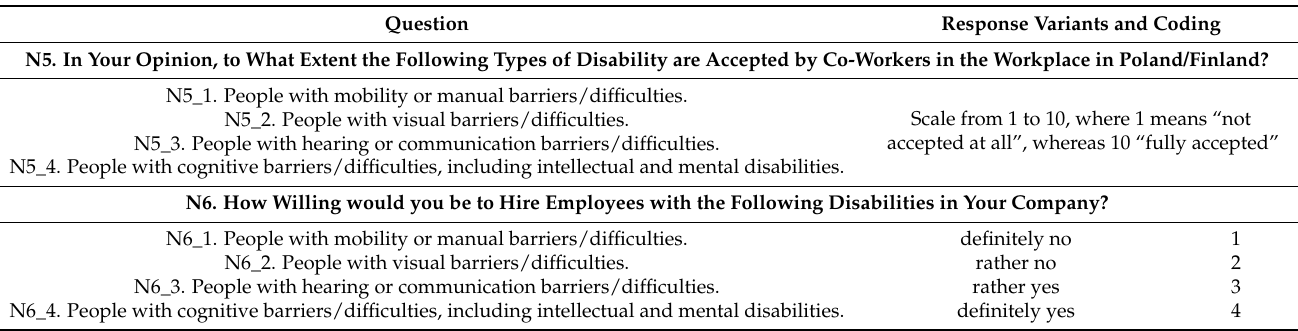
Table A1. Analysed questions from the proprietary